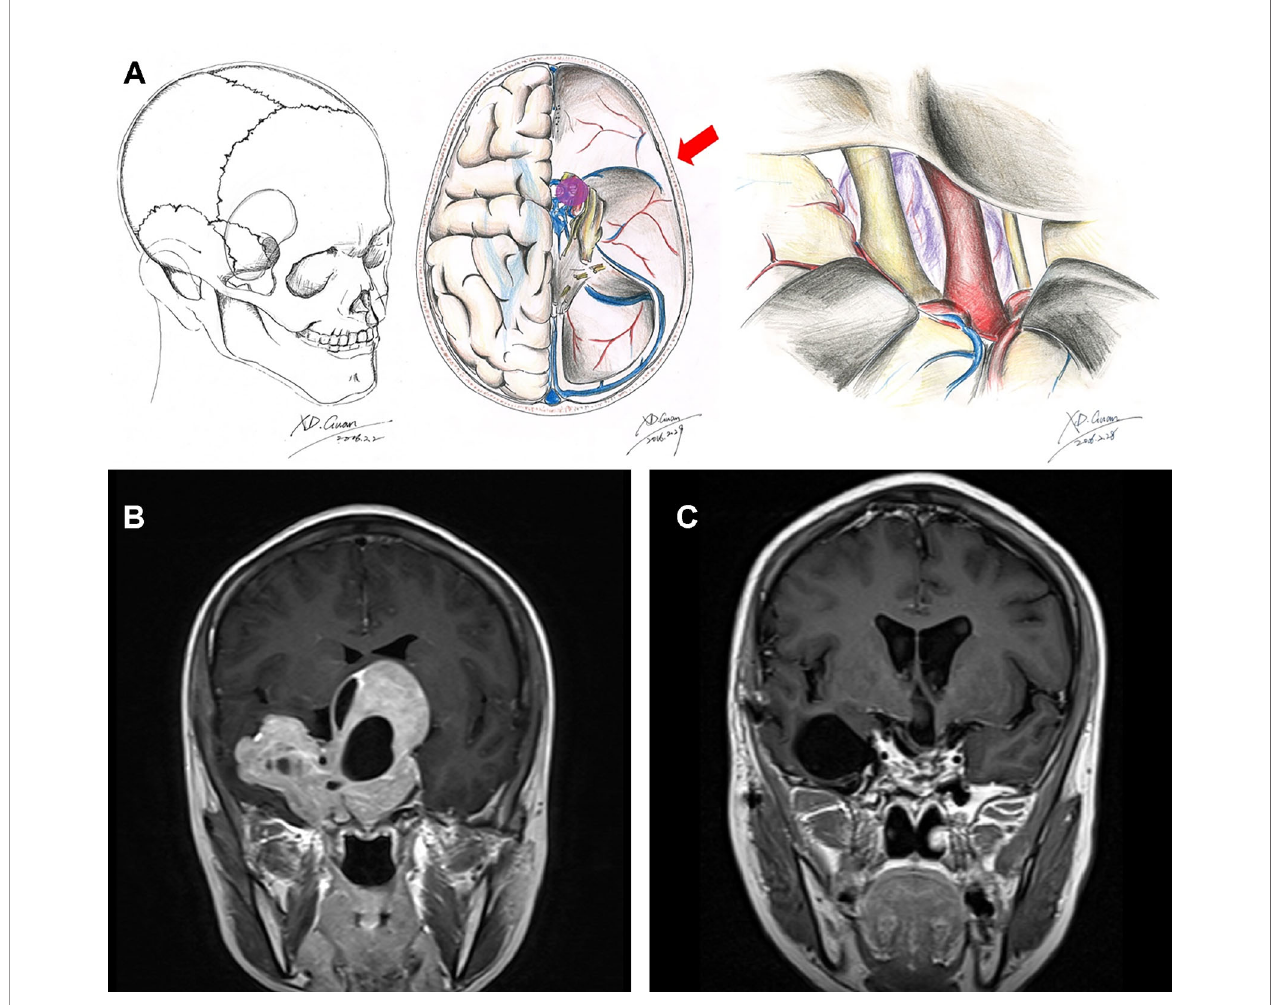
FIGURE 2 | Schematic diagram and MRI images of the frontotemporal approach. Schematic diagrams of incision, surgical fi eld, and microanatomy of frontolateral approach (A) . Preoperative (B) and 3-month postoperative (C) coronal enhanced MRI images of a giant pituitary adenoma in Knosp grade 4 that underwent the frontotemporal